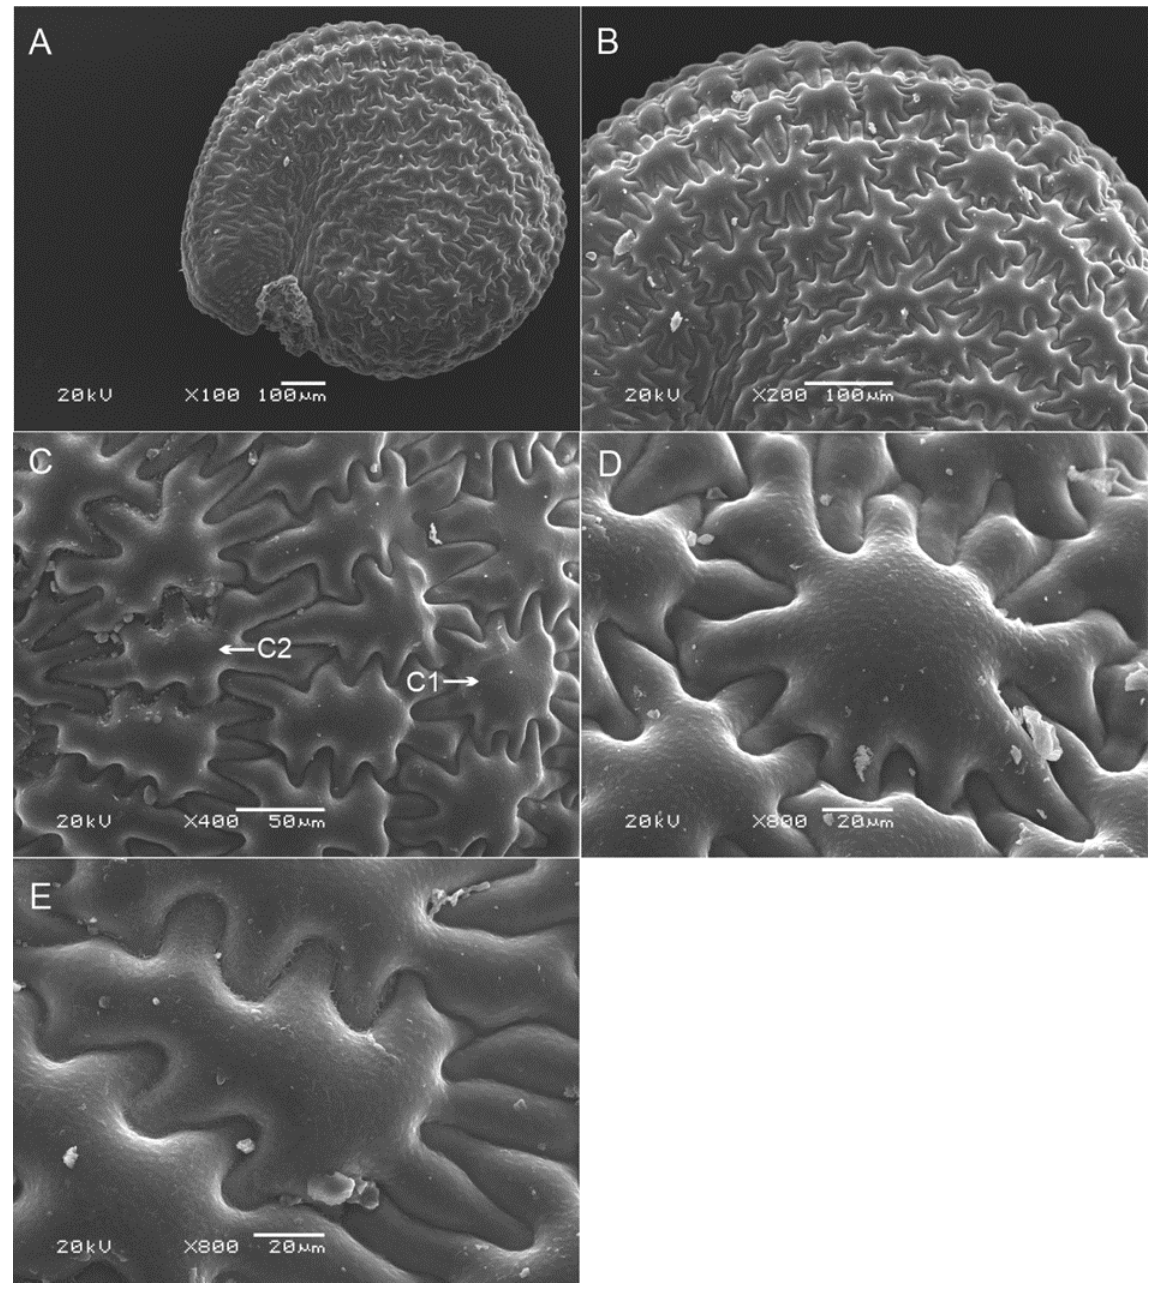
Figure 5 Portulaca nitida (SEM). General view of the seed ( A ). e seed surface ( B,C ). Isodiametric cell ( C1 ), elongated cell ( C2 ); general view of the cells ( D,E ).